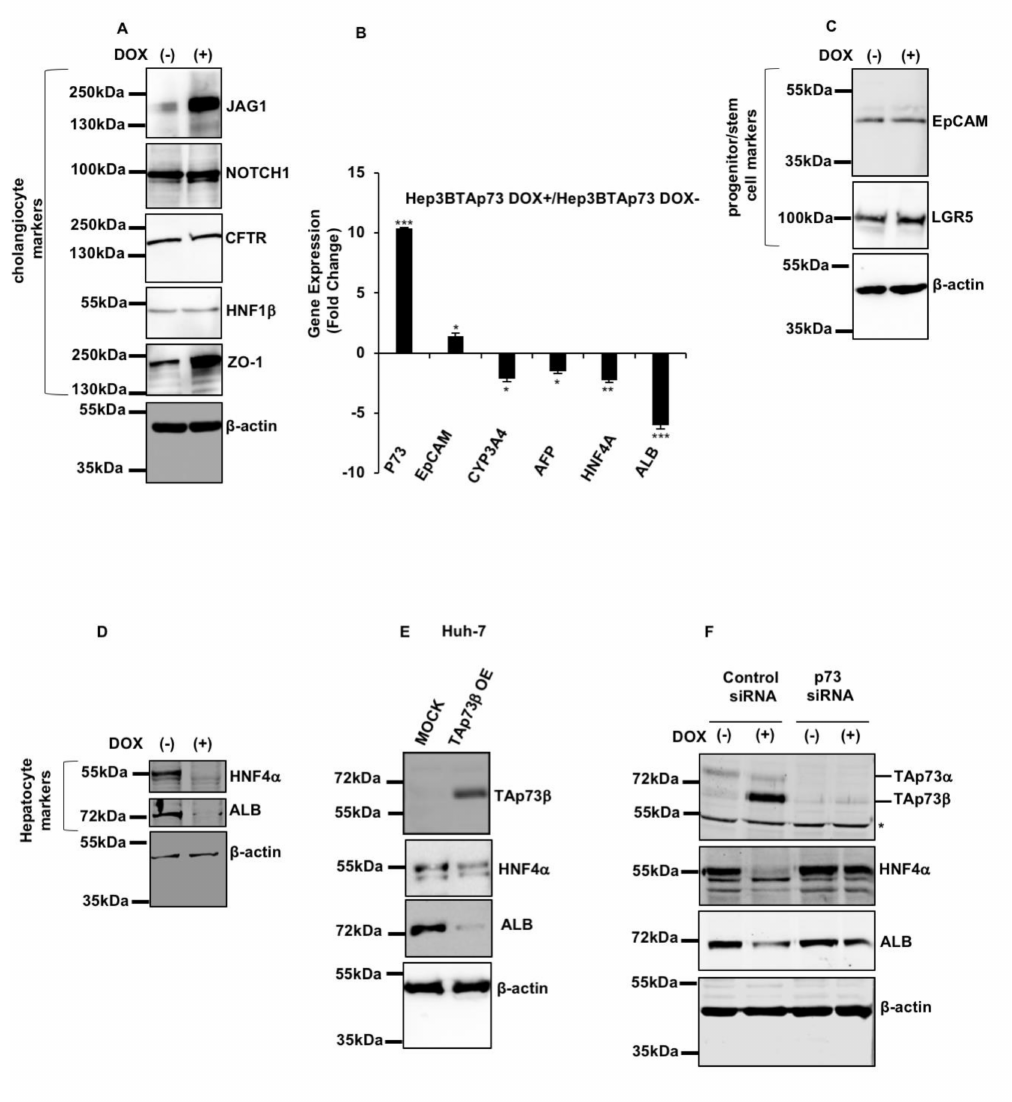
Figure 5. TAp73 β induced the expression of cholangiocyte promoting genes (JAG1, NOTCH1, ZO-1) while repressing hepa- tocyte fate markers (CYP3A4, AFP, HNF4 α , ALB) without affecting progenitor/stem marker (EpCAM, LGR5) expression. Hep3BTAp73 β cells were treated with Doxycycline (1 µ g/mL) to induce TAp73 β expression for 72 h and cell lysates and RNA were obtained, then western blot and RT-PCR were performed. ( A ) Western blotting of cholangiocyte markers JAG1, NOTCH1, CFTR, HNF1 β , ZO-1 (n = 2). ( B ) EpCAM progenitor/stem cell marker and hepatocyte markers, CYP3A4 , AFP , HNF4 α and ALB expressions were examined by RT-PCR. GAPDH was used as a housekeeping gene. Column graphs show the fold change and calculated by using the 2 − ∆∆ Ct method. * p < 0.05, ** p < 0.001 and *** p < 0.0001. ( C ) Western blotting of progenitor/stem markers EpCAM, and LGR5 (n = 2). ( D ) Western blotting of hepatocyte markers ALB and HNF4 α (n = 2). ( E ) Huh7 cells were transiently transfected with TAp73 β and, HNF4 α and ALB protein levels were studied by western blotting. ( F ) Doxycyline-treated and untreated Hep3BTAp73 β cells were transfected with p73siRNA and scrambled siRNA, respectively. Western blot analysis for p73, HNF4 α and ALB expression in control siRNA and p73 siRNA transfected Hep3BTAp73 β cells with or without doxycycline (1 µ g/mL) induction (n = 2). * Non-specific